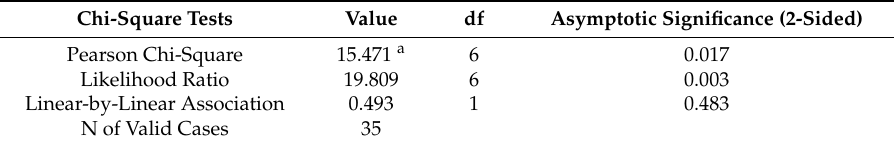
Table A6. Chi-square tests: Game * Gender.